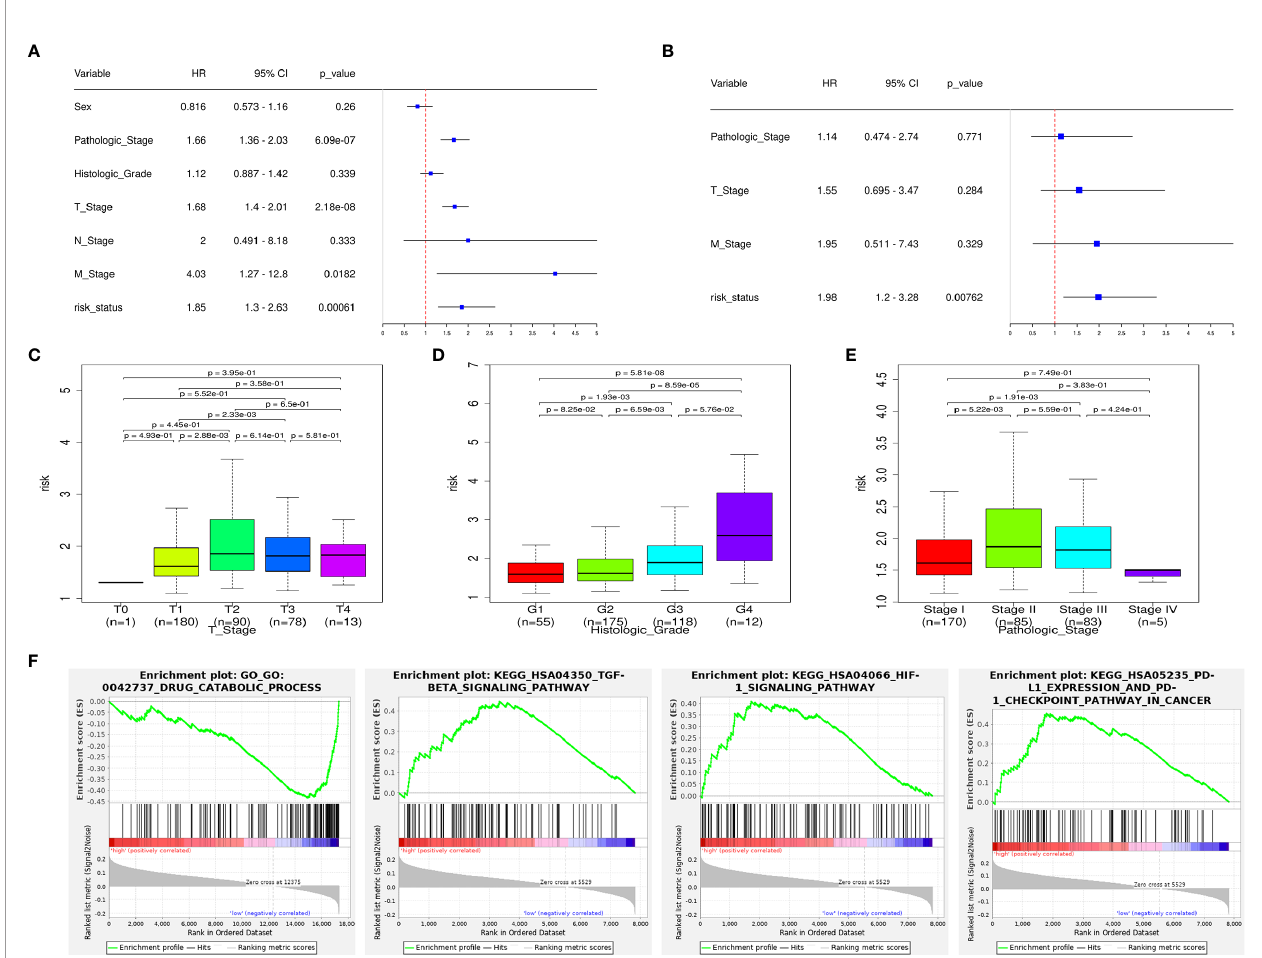
FIGURE 5 | The signature has an independent predictive power and is closely related to the clinical parameters. (A) Univariate COX regression analysis shows that the pathologic stage, T stage, M stage, and risk status are all related to the overall survival. (B) Multivariate COX regression analysis shows that only the risk status obtained from the signature can be used as an independent prognostic factor. (C) Risk scores of patients in the T-stage differ by stage. (D) Risk scores of patients in the histologic-grade differ by grade. (E) Risk scores of patients in the pathologic-stage differ by stage. (F) GSEA results: the TGF- b signaling pathway, HIF-1 signaling pathway, PD-L1/PD1 checkpoint pathway are enriched in the high-risk group, drug catabolic process is enriched in the low-risk